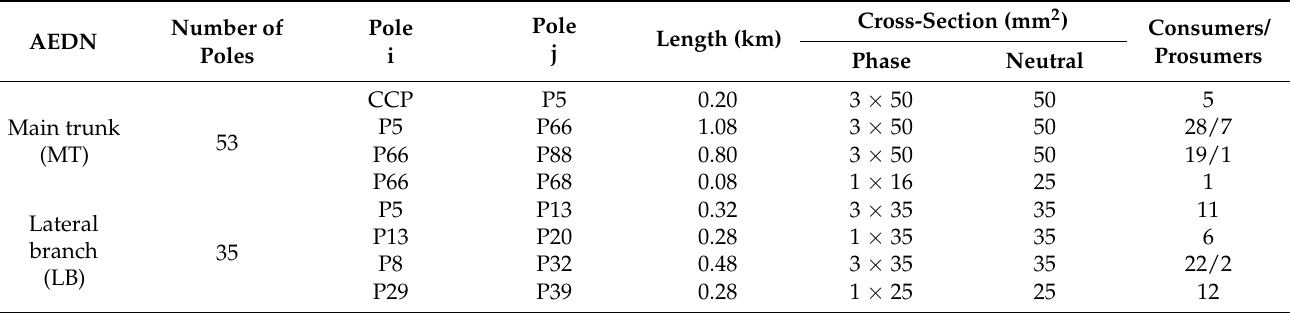
Table 4. The topology data associated with the analysed AEDN.